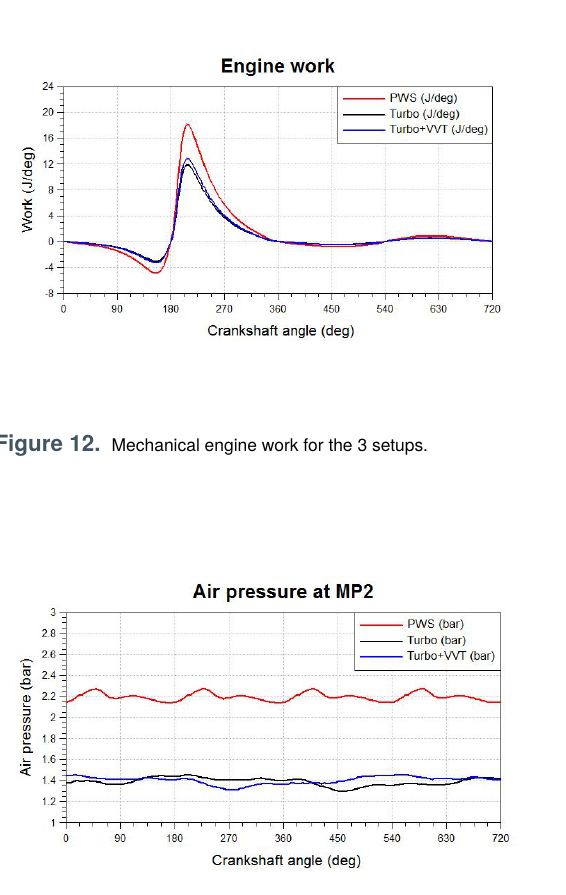
Figure 13. Air pressure at measuring point 2 in the simulation for the 3